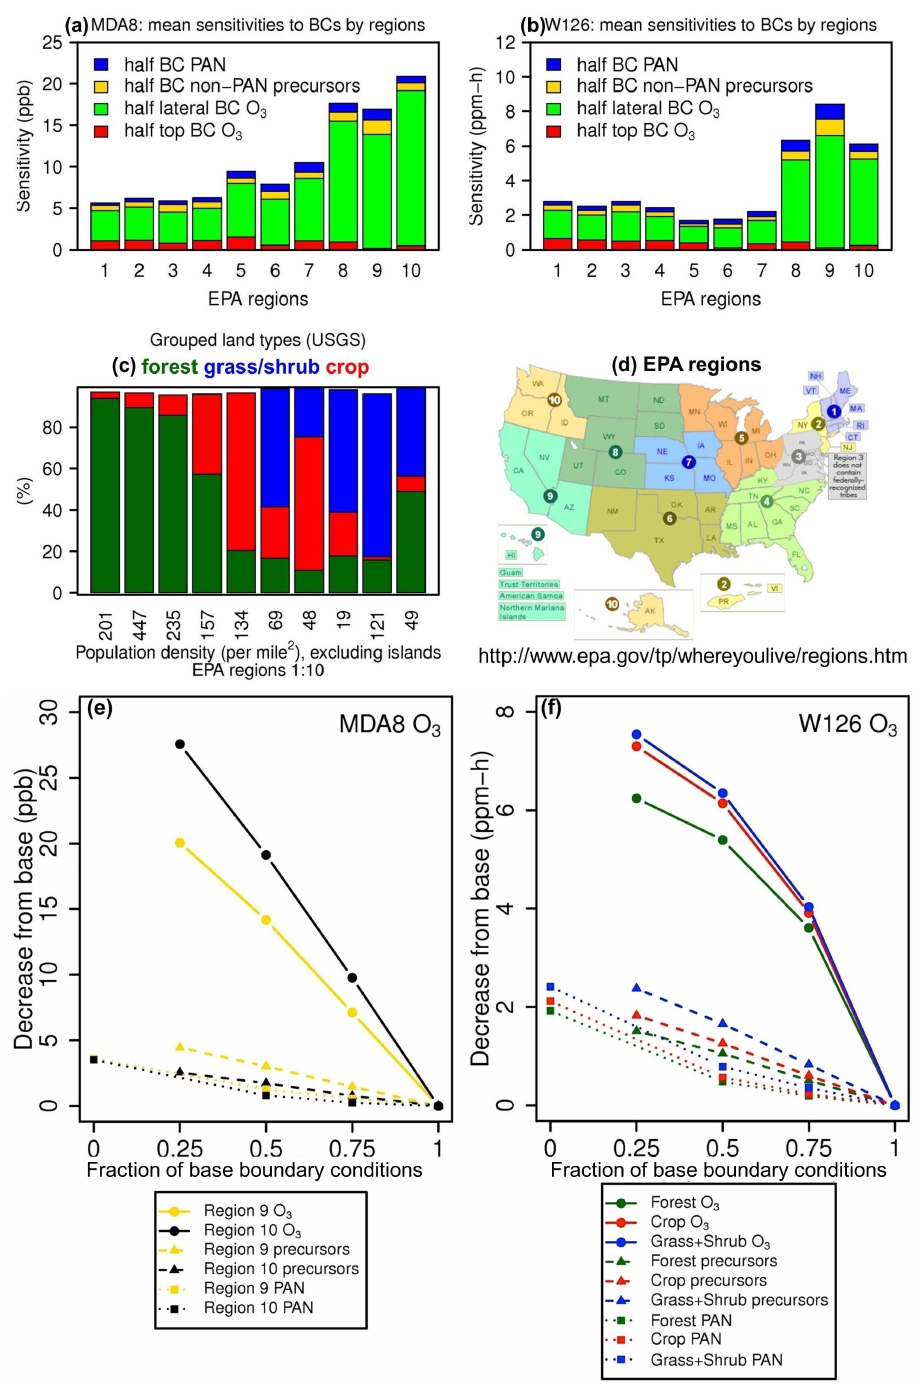
Fig. 3. Surface (a) MDA8 and (b) W126 responses to perturbations in boundary conditions in the 60km/18 layer grid, shown by ten EPA regions. (c) Fractions of the grouped USGS land types (bar) and population densities (text below the bar) in ten EPA regions. (d) The ten EPA regions; Surface (e) MDA8 and (f) W126 responses to perturbations of various species in boundary conditions in the 60km/18 layer grid, shown by geographical regions (EPA Regions 9 and 10) and grouped USGS land types, respectively (“precursors” in legends: the cases in which CO, NO, NO 2 , NO 3 , HNO 3 , HNO 4 , PAN, N 2 O 5 in BCs were